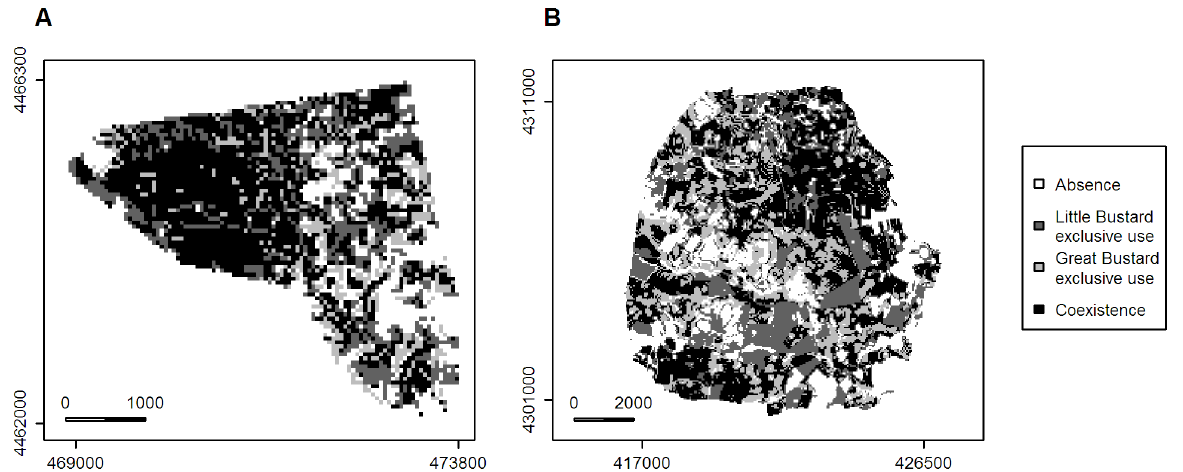
Figure 3. Coexistence maps of Little and Great Bustards. Maps of Little Bustard and Great Bustard coexistence for 2011 in Campo Real (A) and 2008 in Calatrava (B), showing also areas of exclusive use and areas in which both species were predicted to be absent. The scale bar is given in